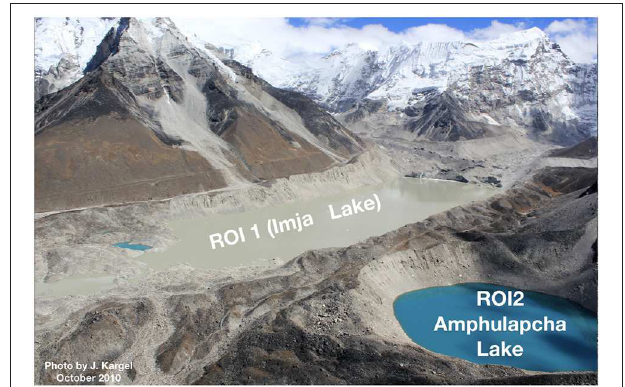
FIGURE 1 | Low altitude oblique air–photo of Everest–area lakes and our regions of interest, ROI 1 (Imja Lake) and ROI 2 (Amphulapcha Lake). These lakes contain, respectively, large amounts of coarse silt and smaller amounts of fine silt, resulting in pronounced color differences. Both lakes are optically thick, except very near their